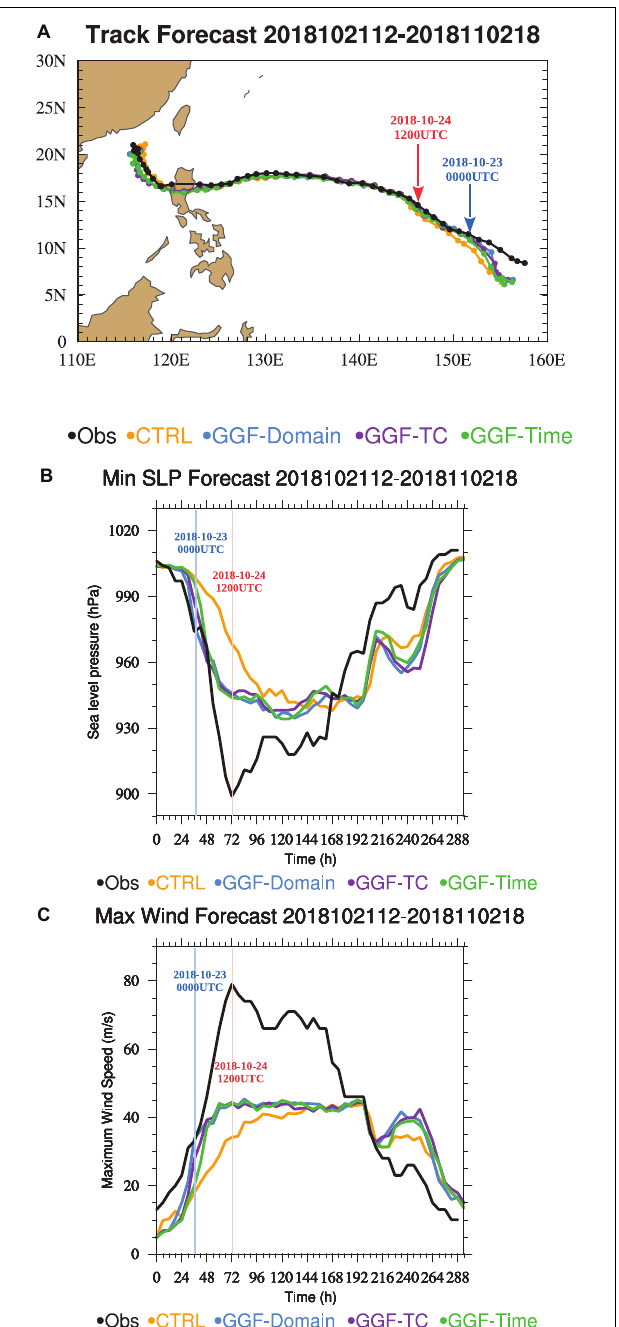
FIGURE 9 | Six hour ensemble mean forecasts of (A) track, (B) minimum sea level pressure, and (C) maximum wind speed for typhoon Yutu (2018). Black line denotes the observed value, orange, blue, purple and green lines display the results of experiments CTRL, GGF-Domain, GGF-TC and GGF-Time respectively.